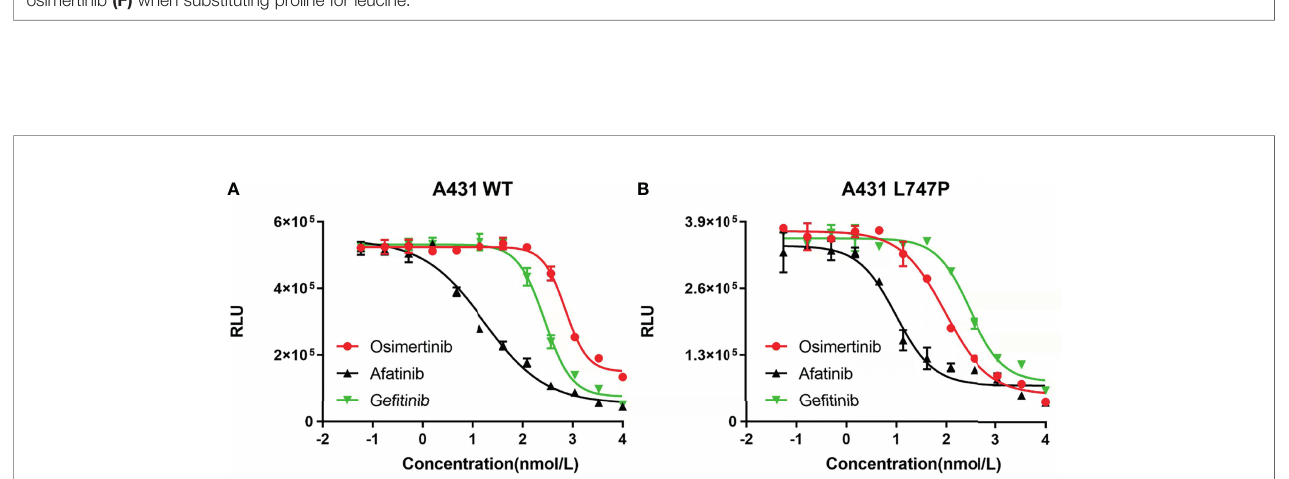
FIGURE 4 | The kinase inhibition activity of 1G to 3G EGFR TKIs against EGFR wild type (A) and p.L747P-mutant (B) cell